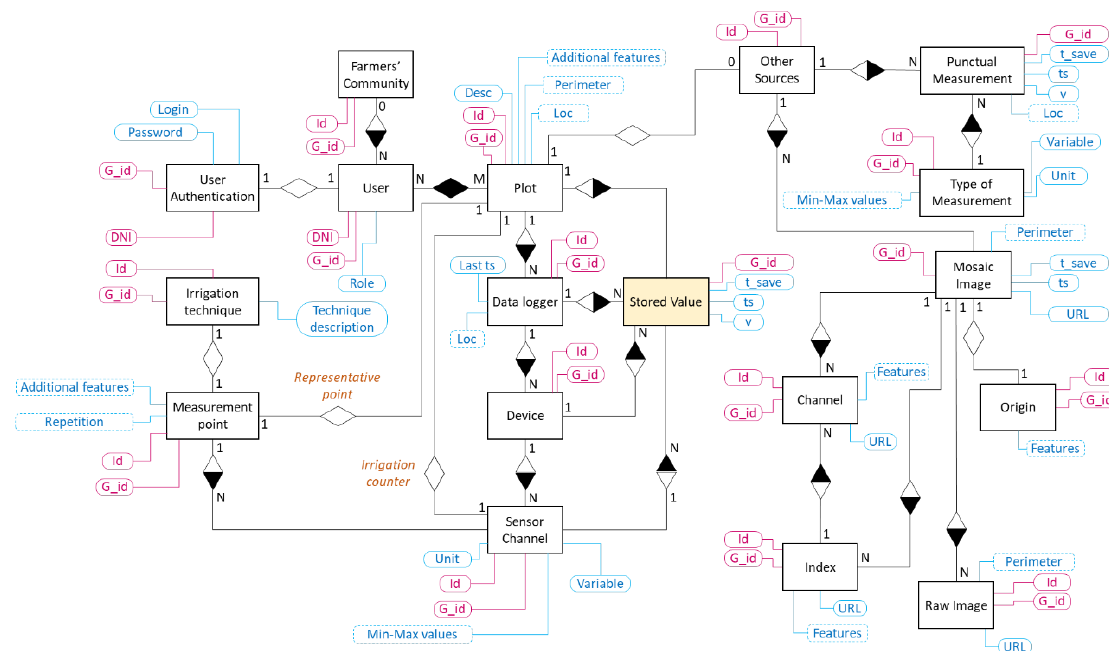
Figure 3. Data model which allows the main entities stored in the Datastore to be defined. Entities are implemented as a Java class whose private attributes are the properties attached to each one. Only the main attributes are represented in this data model. All the entities are created and updated from the WEB application according to the users’ requirements. The Stored Value entities are updated by the data loggers deployed at crop level.